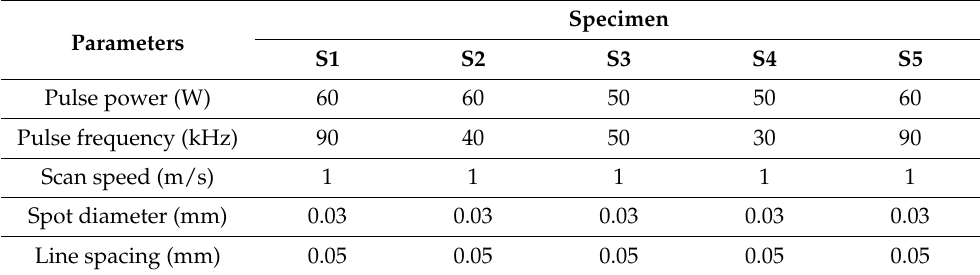
Table 5. Laser surface polishing treatment parameters used in this